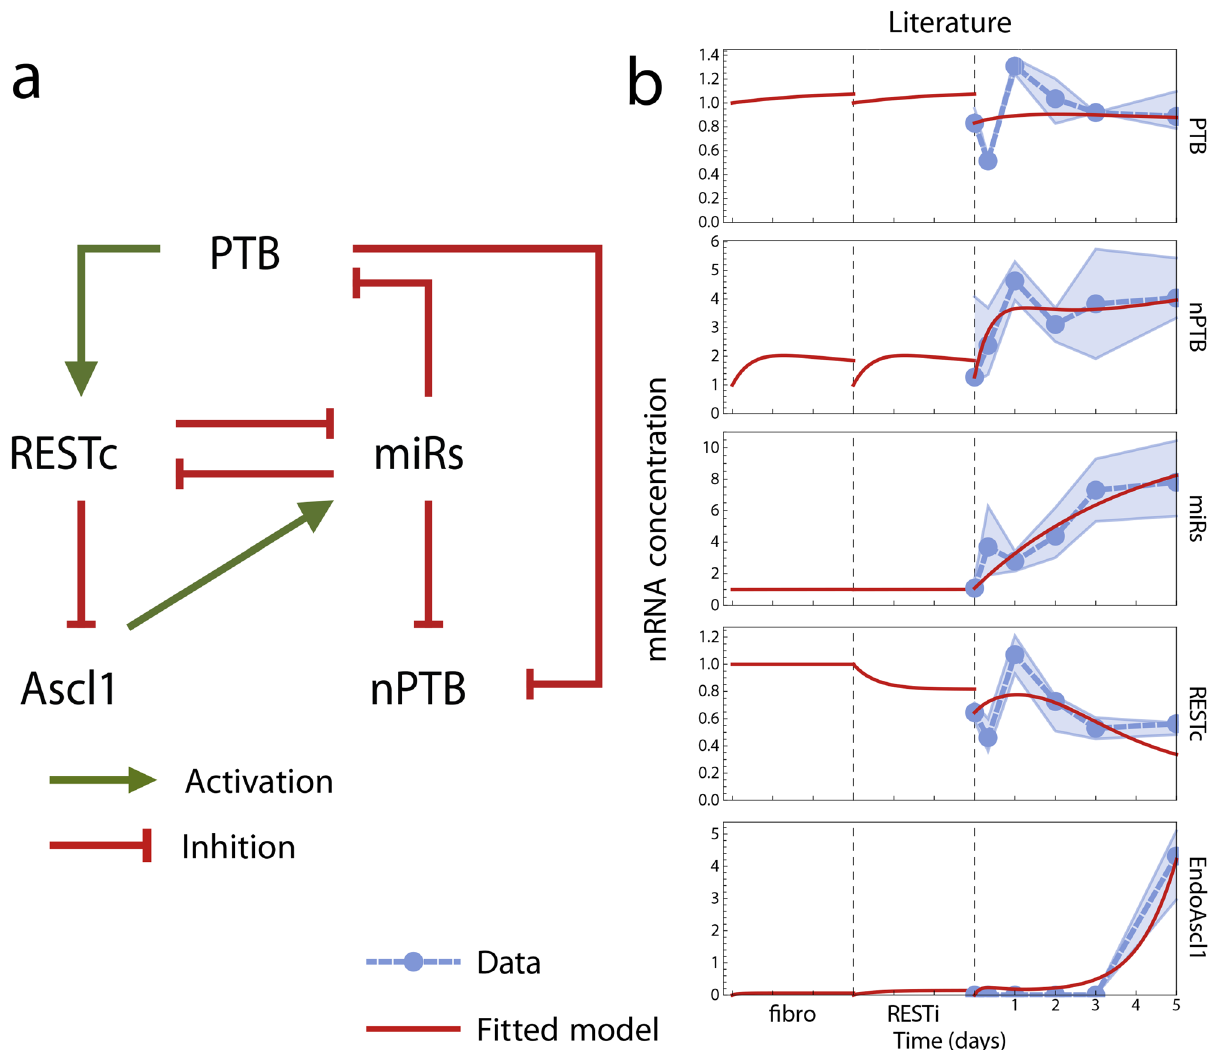
Figure 2. Known interactions are not sufficient to explain observed reprogramming dynamics. ( a ) Literature- based network topology. Green pointed arrows represent activations, red flat arrows represent inhibition interactions. ( b ) Predicted transcription levels according to quantitative model based on gene network in A, fitted to our experimental data. Time scale is divided in three phases, corresponding to fibroblast, REST knockdown, and conversion stages of the experiment. The plots were made with Mathematica 11.3.0 (Linux version). https ://www.wolfr am.com/mathe matic